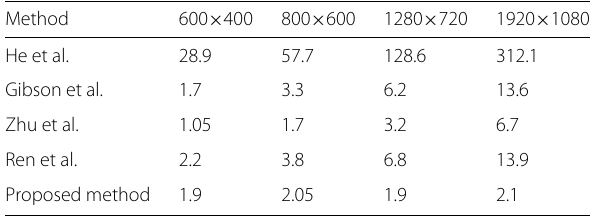
Table 2 Comparative analysis using the Structural Similarity Index Measure (SSIM)